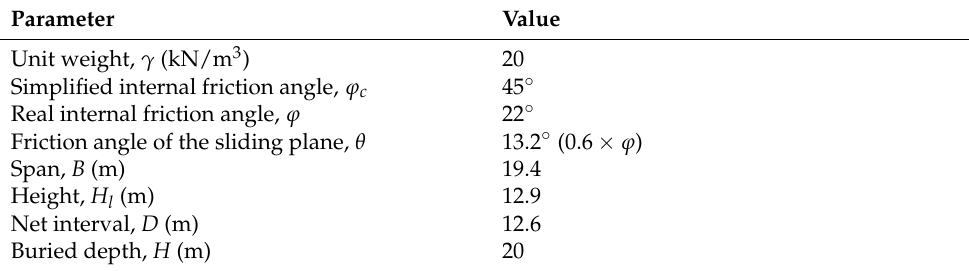
Table 1. The related parameters of Daling Tunnel.